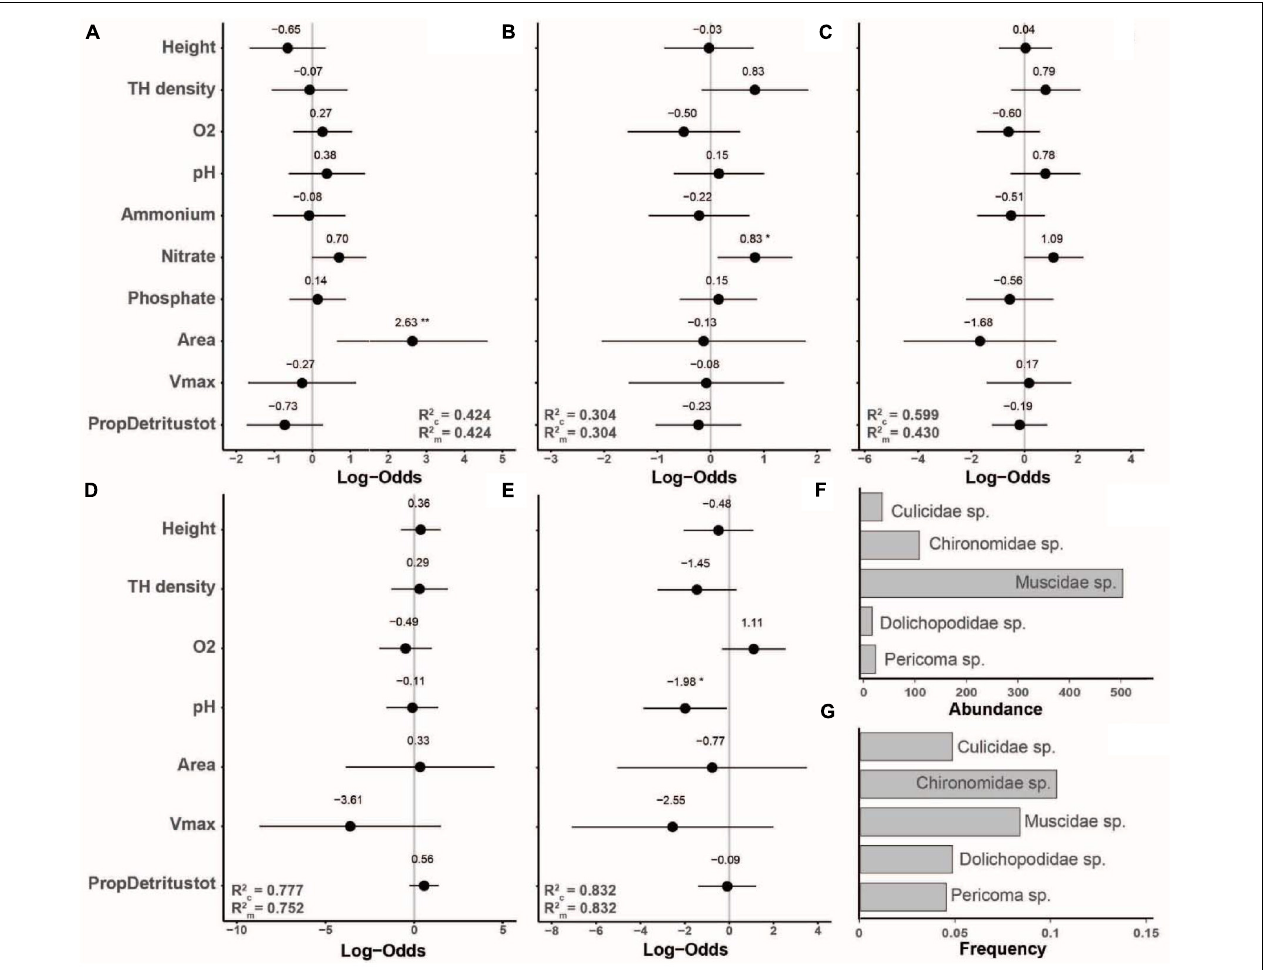
FIGURE 5 | Standardized model coefficients (including conditional and marginal R 2 -values) of generalized linear mixed effects models with binomial distribution based on occurrence data, showing the importance of tree-hole height above ground, tree-hole density, tree-hole opening area, tree-hole maximum water volume (Vmax), water chemistry [dissolved oxygen concentration (O 2 ), pH, and ammonium, nitrate and phosphate concentrations] and total amount of detritus relative to Vmax (PropDetritustot) in determining the occurrence of less frequently observed insect species that were observed in > 10 but < 88 tree holes. (A) Diptera, Culicidae sp., occurrence in n = 15 tree holes; (B) Diptera, Chironomidae sp., n = 32; (C) Diptera, Muscidae sp., n = 26; (D) Diptera, Dolichopodidae sp., n = 15; (E) Diptera, Psychodidae, Pericoma sp., n = 14. Please note that in (D,E) a reduced model was used because there were many missing values. (F,G) show the total abundance and the frequencies of occurrence of the five species, respectively. * p < 0.05, ** p <